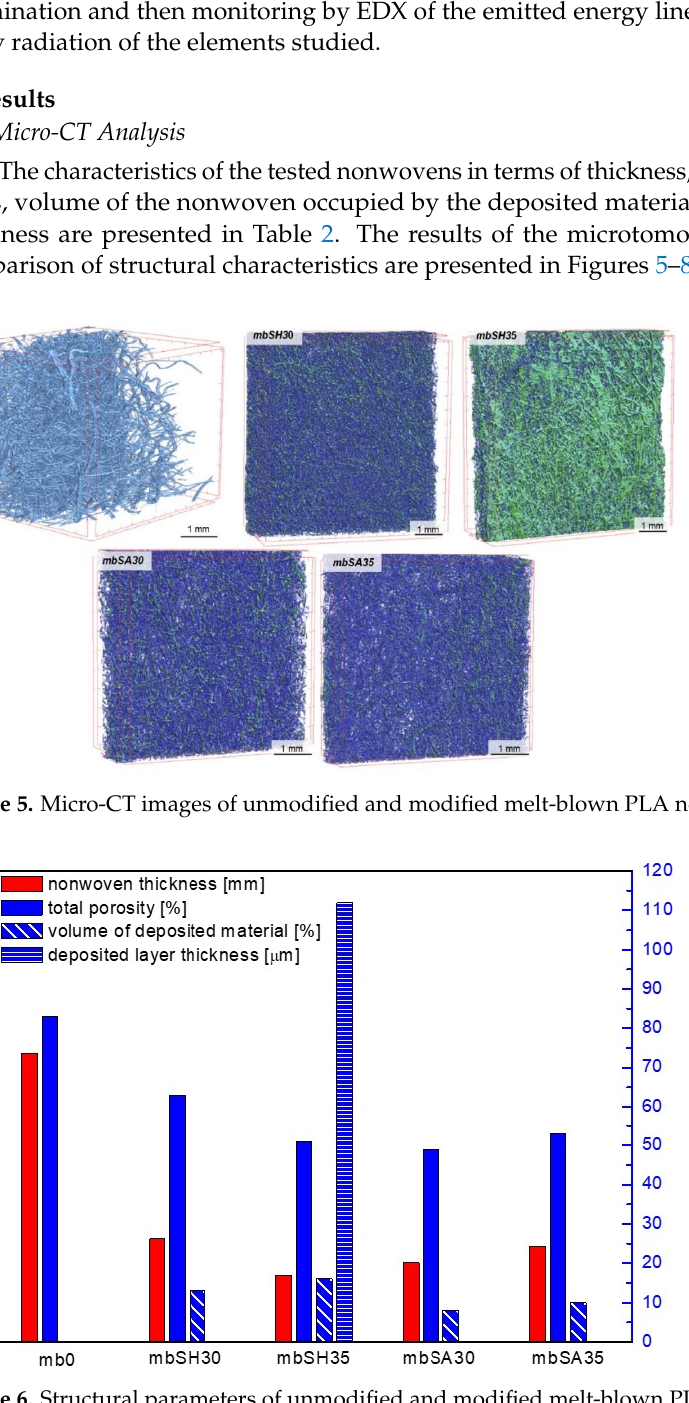
Figure 7. Micro ‐ CT images of unmodified and modified spun ‐ bonded PLA nonwoven fabrics.